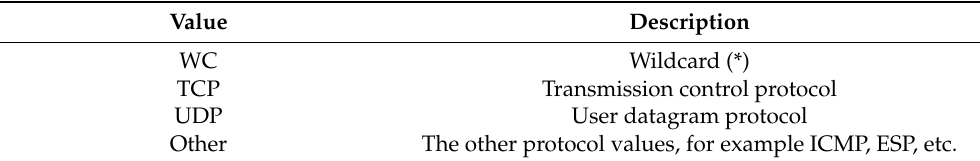
Table 5. Four classes of the protocol field.